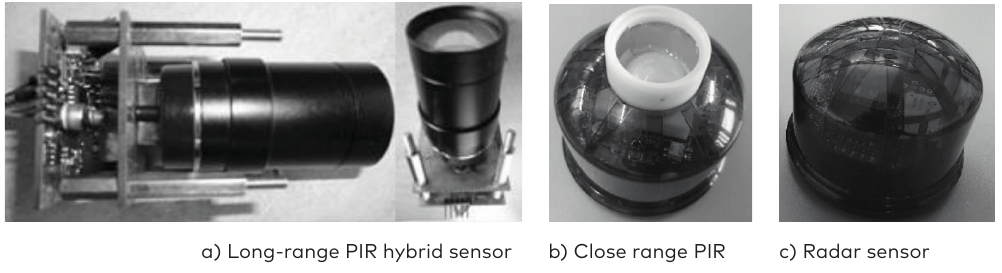
Figure 4. The developed sensor prototypes